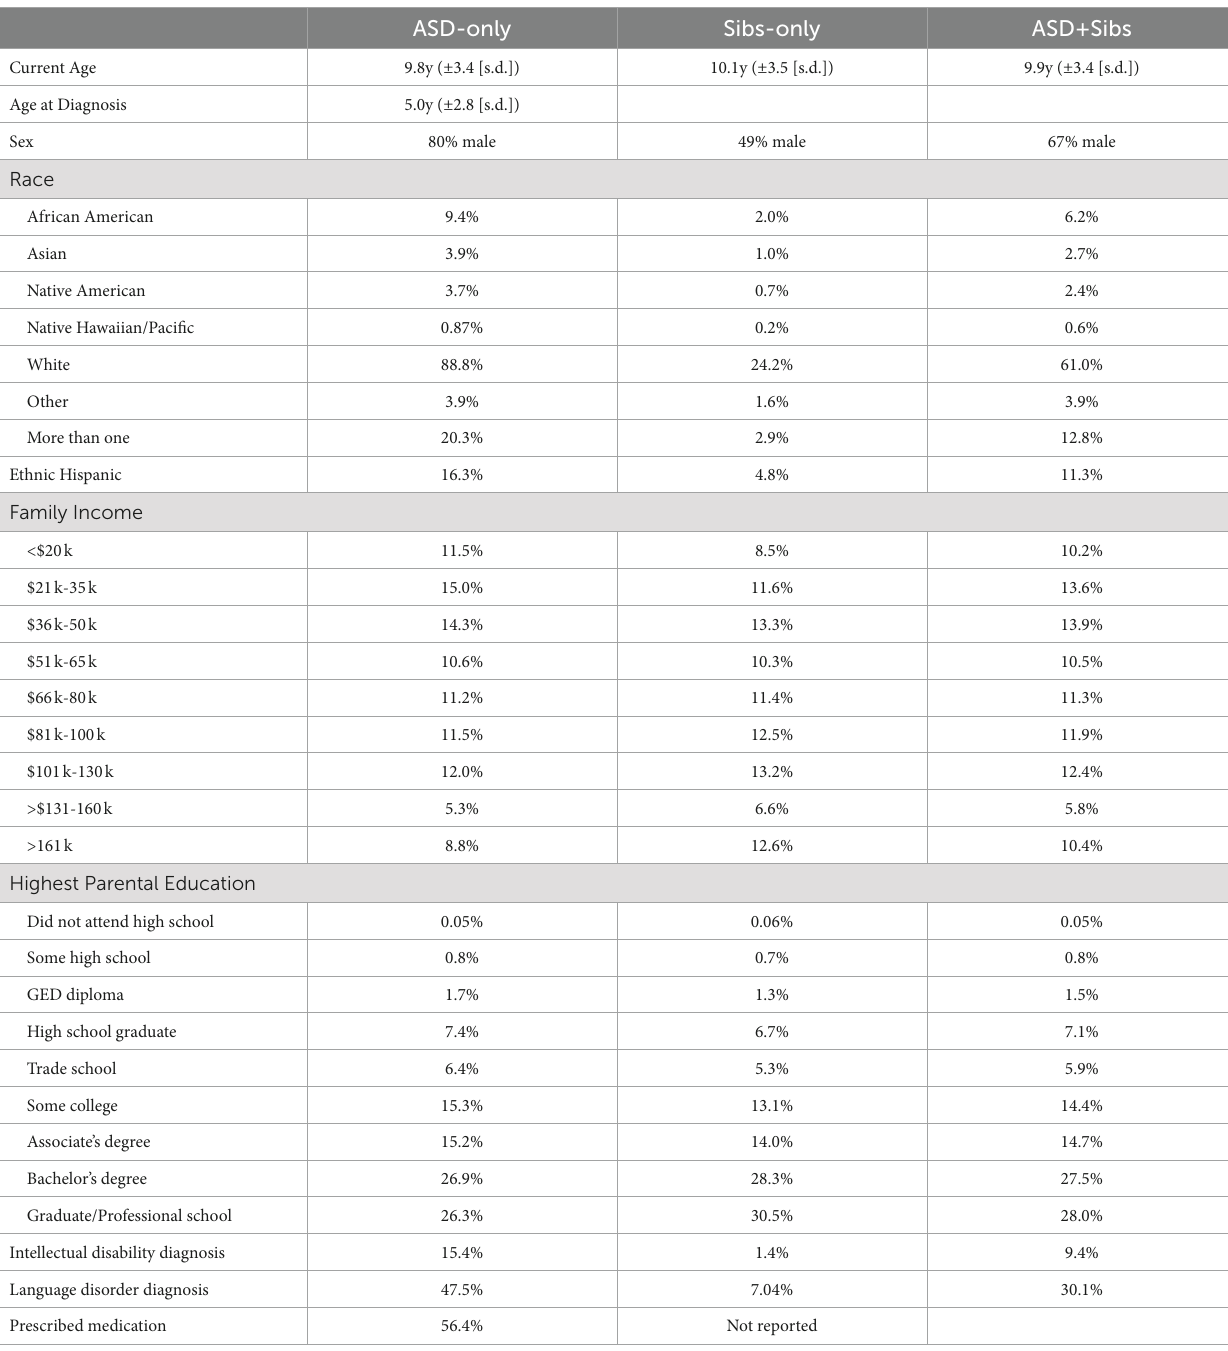
TABLE 1 Demographic